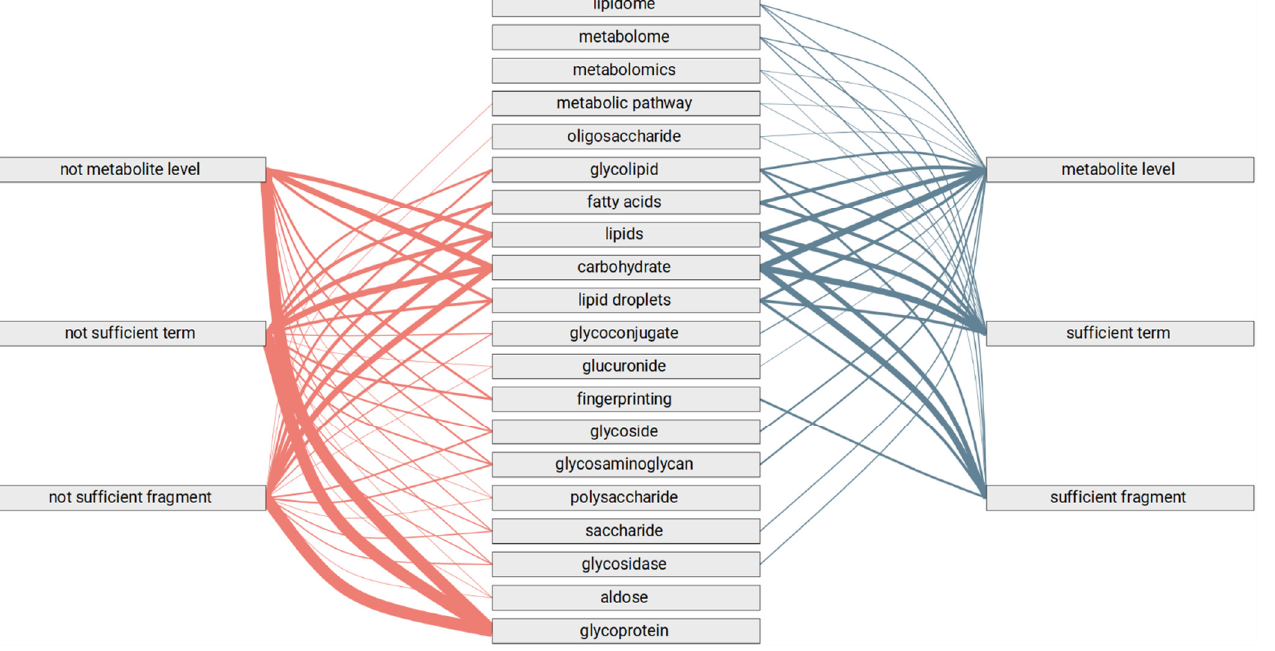
Figure 7. Association between the terms from the metabolite category of the dictionary and answers obtained during the manual review. Thicker lines connecting the term and an answer mean more cases. Blue lines connect terms and positive answers. Red lines connect the terms and negative answers.